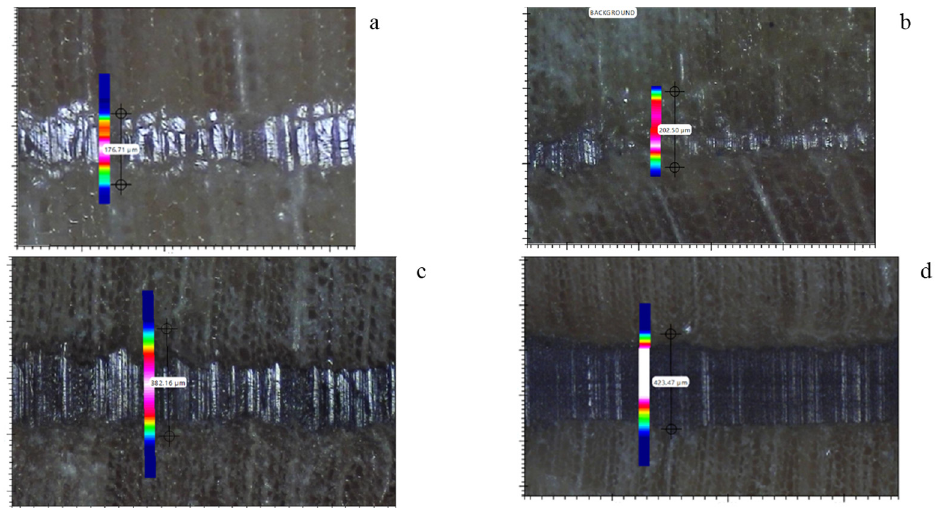
Figure 3. Selected examples from chemical spatial imaging analysis which show PLA bondline thickness to vary substantially, ranging from 60 mm and 340 mm across the 5-ply panel sets (( a ): 140 ◦ C, 600 s, outer bondline 176.71 µ m; ( b ): 160 ◦ C, 480 s, outer bondline 202.50 µ m; ( c ): 180 ◦ C, 480 s, outer bondline 382.16 µ m; ( d ): 160 ◦ C, 600 s, outer bondline 423.47 µ m).